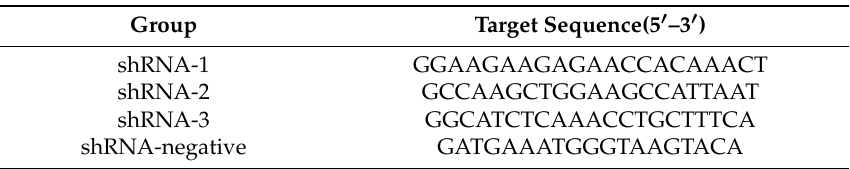
Table 3. Target sequences of mouse XBP1.